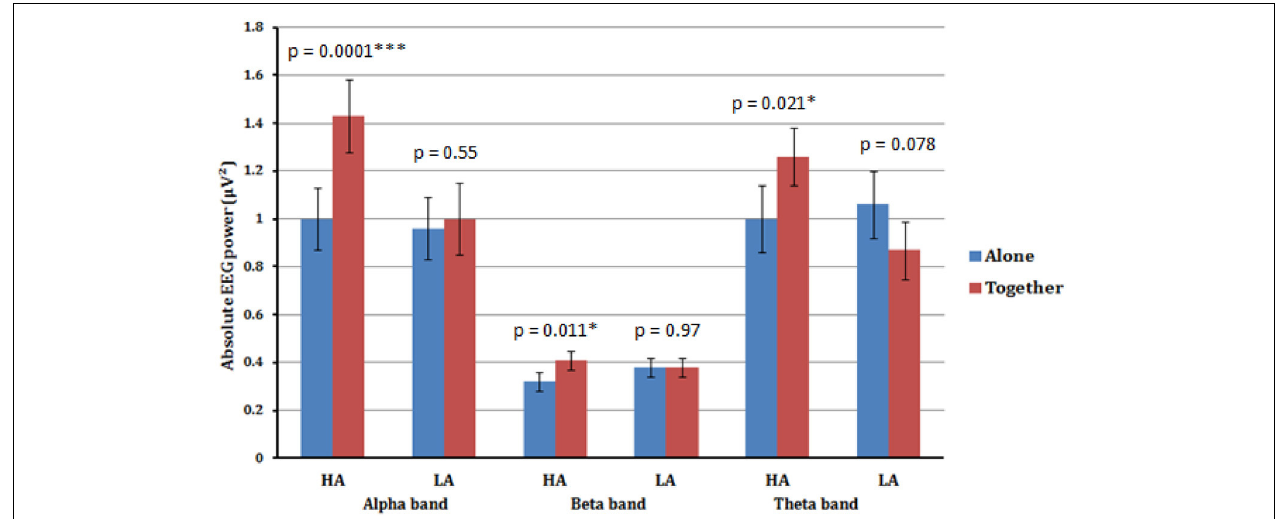
FIGURE 2 | Estimated marginal means (an average value from all four scalp areas) for alpha, beta, and theta frequency bands of high anxious (HA) and low anxious (LA) attached participants in A (blue) vs. T (red) conditions. Significant increase in alpha, beta, and